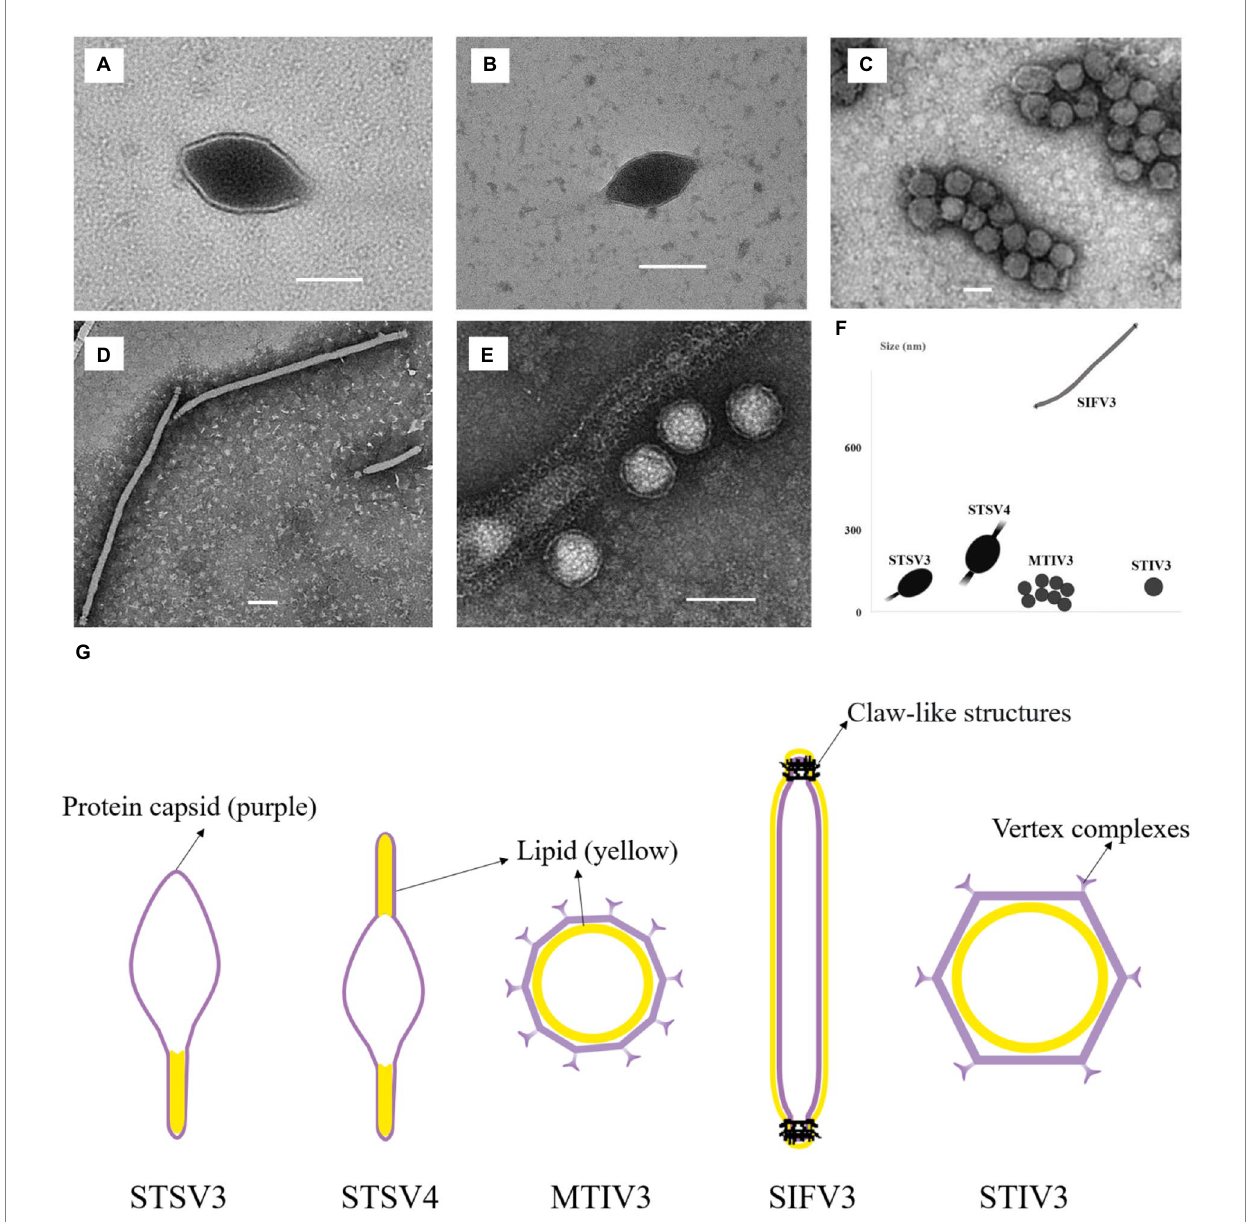
FIGURE 3 Transmission electron micrographs of the five isolated viruses in the study. (A,B) STSV3 and STSV4 (tailed spindle-shaped virions); (C) MTIV3 (spherical virions); (D) SIFV3 (filamentous virions); (E) STIV3 (spherical enveloped virions); (F) The morphology and size of these viruses. (G) Schematic representation of the five viruses with the lipid membrane (Reuter et al., 2005; Wagner et al., 2017; Han et al., 2022; Wang et al., 2022). The inside or outside membrane is illustrated as a yellow layer, and the protein capsid is depicted in purple. (A–E) Scale bar, 100 nm. The viral particles are not drawn in scale in (G)